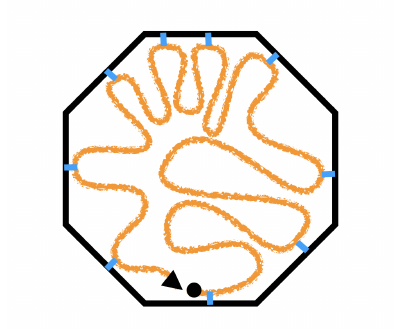
Figure 12. Frontside view of a polygonal schema with a simple closed loop traced in a counterclockwise direction—the loop can only touch the bounding polygon in a strictly counterclockwise, cyclical order, and only on its outer (or right)